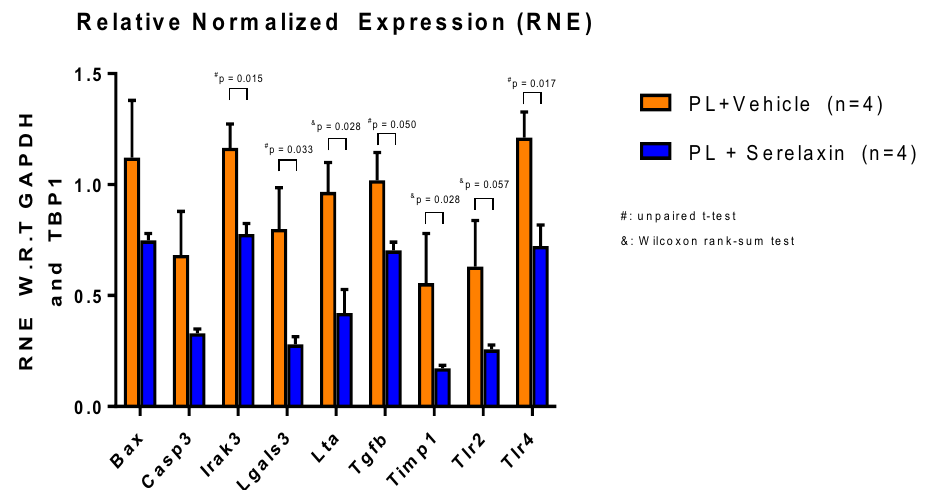
Figure 3. Gene expression profile upon chronic treatment with serelaxin. Expression of pro-inflammatory (Tlr2, Tlr4, Lta, Irak3), pro-apoptotic (Bax, Casp3), and profibrotic genes (Timp1, Tgfb, Lgals3) is significantly lower in animals receiving chronic serelaxin treatment. For all the data sets, unpaired T-test was utilized. However, when non-normality was detected, Wilcoxon rank-sum test was used for pair-wise comparisons. ( PL permanent ligation, RNE W.R.T relative normalized expression, With respect